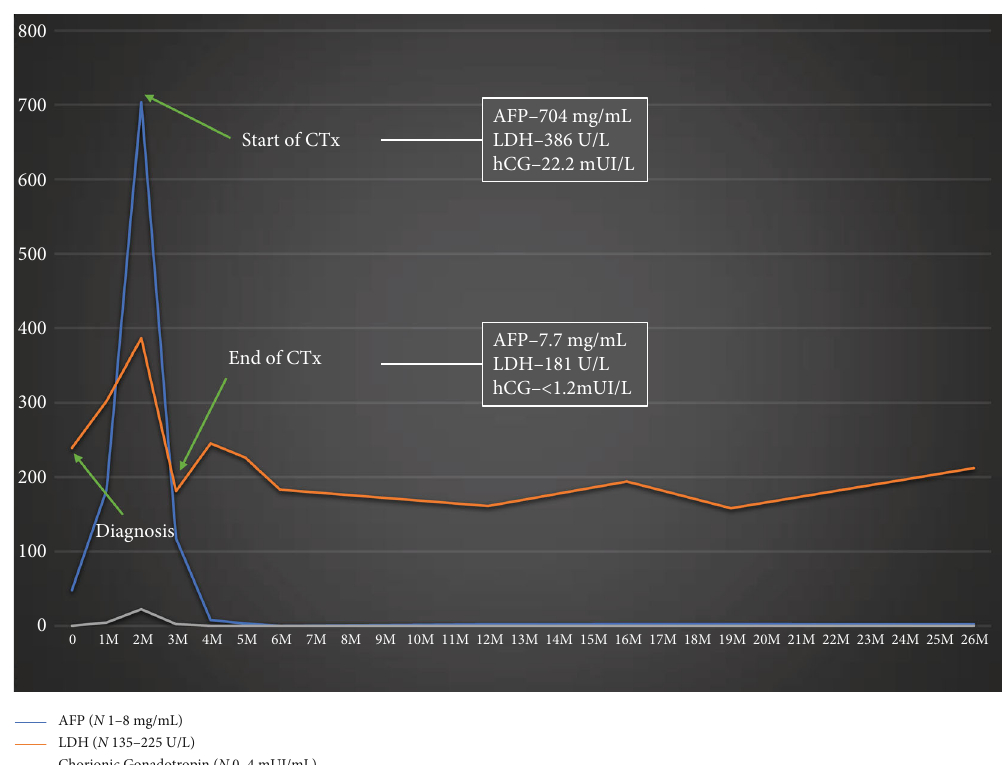
Figure 5: Evolution of tumoral biomarkers serum levels throughout patient follow-up, since diagnosis to the present day. AFP: alpha fetoprotein; LDH: lactate dehydrogenase; hCG: chorionic gonadotropin; CTx: